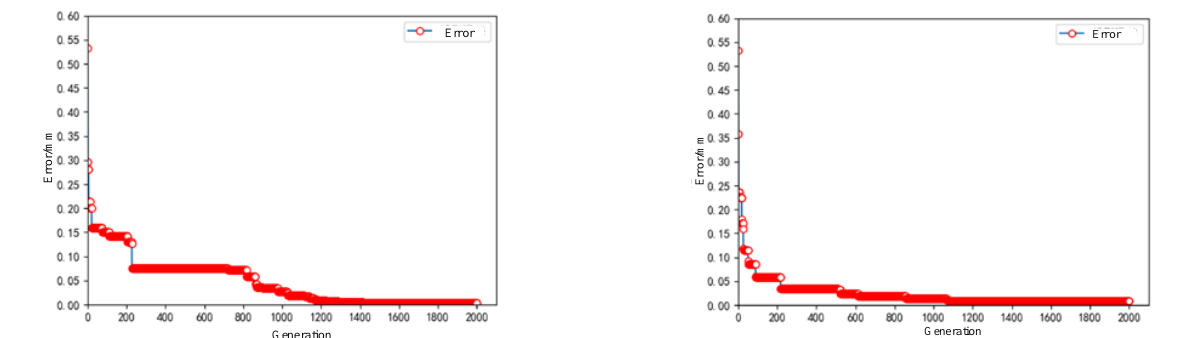
Figure 7. Comparison of the average error of target points for the two optimization strategies.